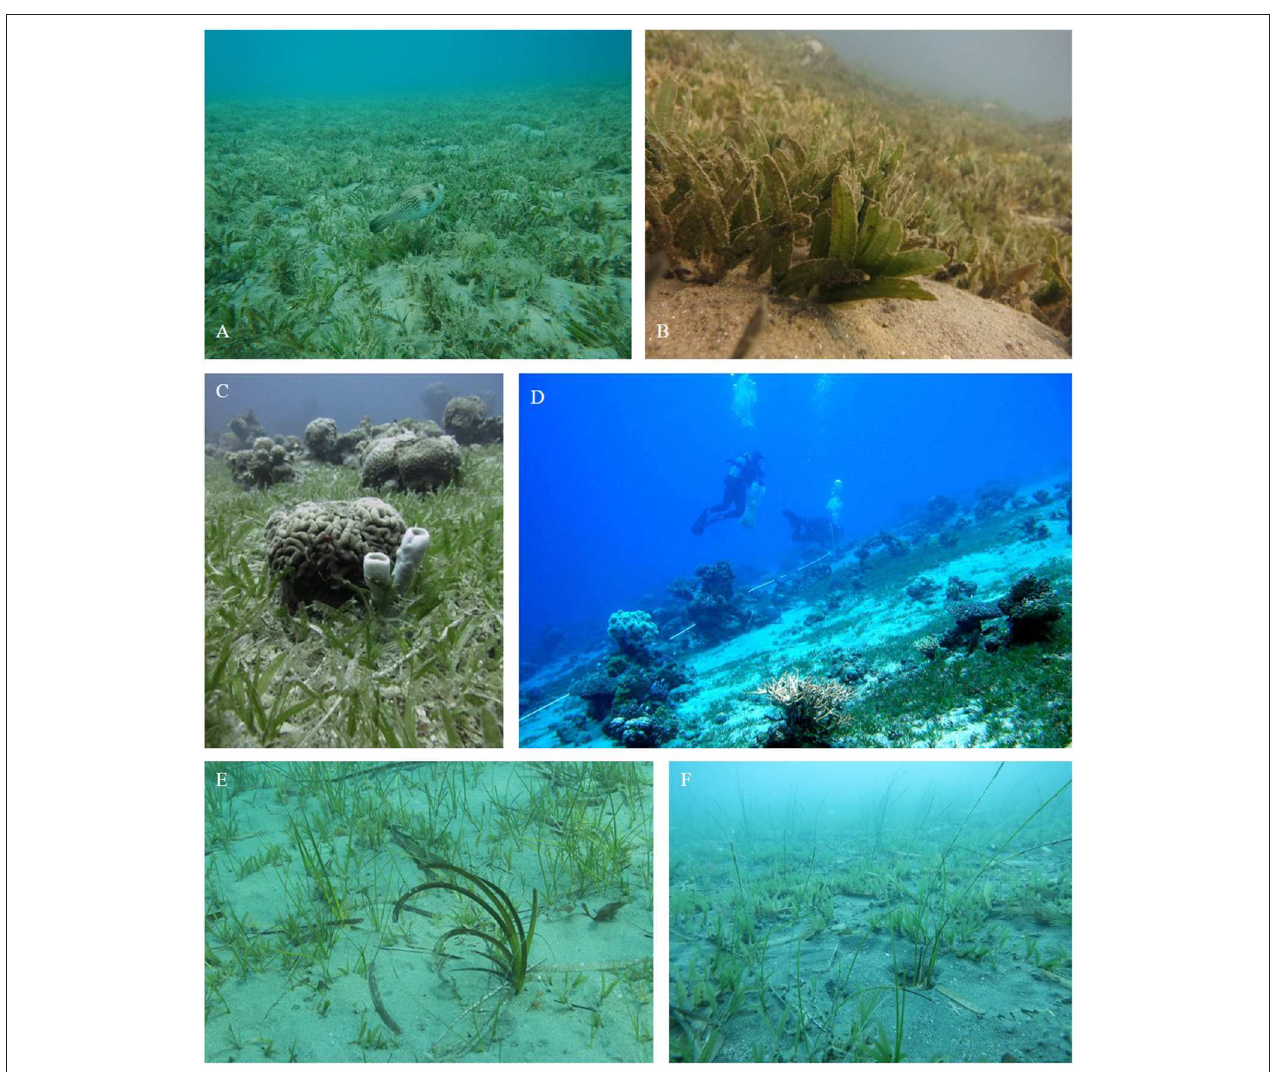
FIGURE 1 | General features of the tropical seagrass Halophila stipulacea . Shown are typical (A,B) shallow (3–6m) and (C,D) deeper (20–50m) meadows growing in the native habitat of the northern tip of the GoA (Eilat, Israel), where H. stipulacea grows in extensive meadows or within neighboring local coral reefs. Shown are also examples of plants growing in the invasive habitat of the Mediterranean (E,F) where H. stipulacea plants grow intermixed with native Mediterranean temperate seagrasses such as Cymodocea nodosa and Posidonia oceanica (Dream café site, Limassol, Cyprus). Photos were taken by Gidon Winters (A–C,F) , Yoni Sharon (D) and Yuval Sapir (E) . All photos in this figure have been obtained with permission from the original copyright